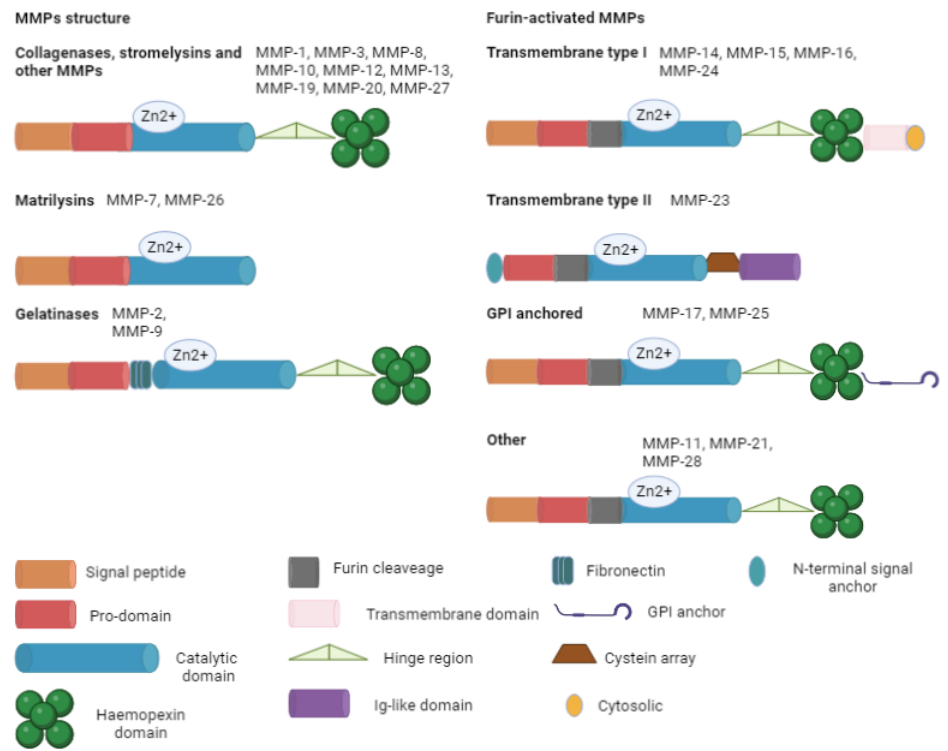
Figure 2. Main MMP structure. All the isoforms are basicly composed of a signal peptide (except for transmembrane type II), a pro-domain, and a catalytic domain. Furin-activated MMPs contain a furin recognition site near the catalytic domain, permitting the intracellular activation of the zymogen. GPI, glycophosphatidylinositol; Zn, zinc. MMPs play a role in inflammation and pain, regulating many functions including the activity and bioavailability of cytokines, growth factors, and chemokines. Further- more, they play a role in tumor invasion, immune chemotaxis, and the regulation of in- flammation in several disease [4 – 20].